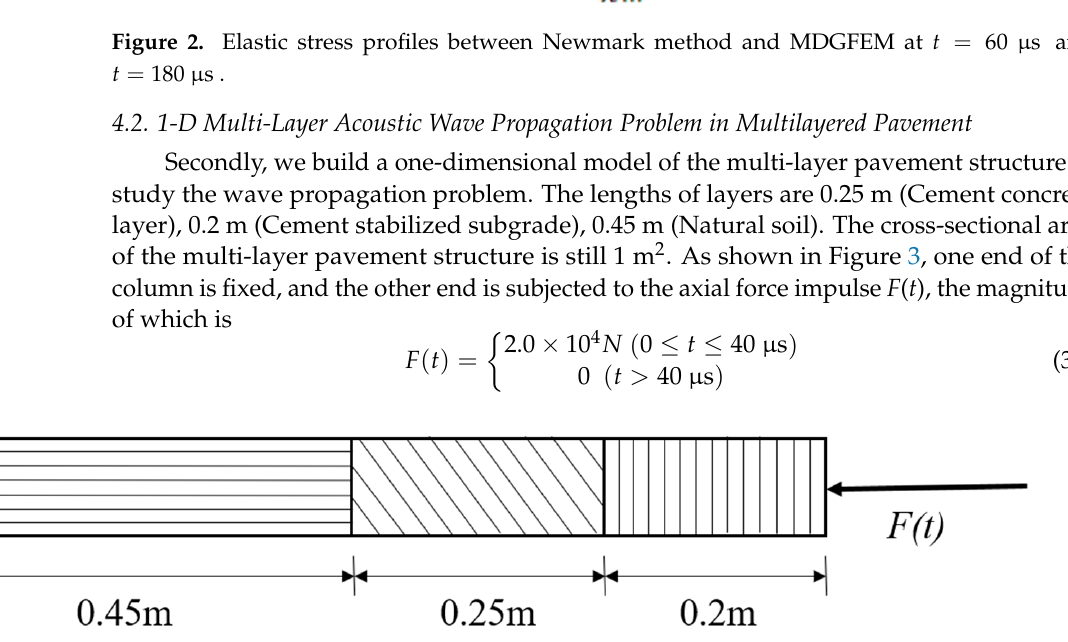
Figure 3. A multi-layer cement pavement structure bearing an impulse load (45 × 1 elements). The cement concrete column is divided into 45 elements along the length, that is, each element is 0.02 m. Figures 4 and 5 give the wave propagation solutions of compression and pressure generation using Newmark method and MDGFEM with a time step size ∆ t = 4.0 × 10 − 6 s by taking two different time levels of the compression and pressure, re- sulting in wave propagation solutions at different time levels of t 1 = 80 µ s and t 2 = 200 µ s for the example. It is remarked that the stress and pressure time-history curves obtained by the Newmark method have obvious spurious numerical oscillations in the pavement interlayer and wave-front regions, while the smooth and continuous stress-pressure curve of MDGFEM proves that the artificial damping added provides a more accurate solution to the wave propagation problem in multilayer pavement.